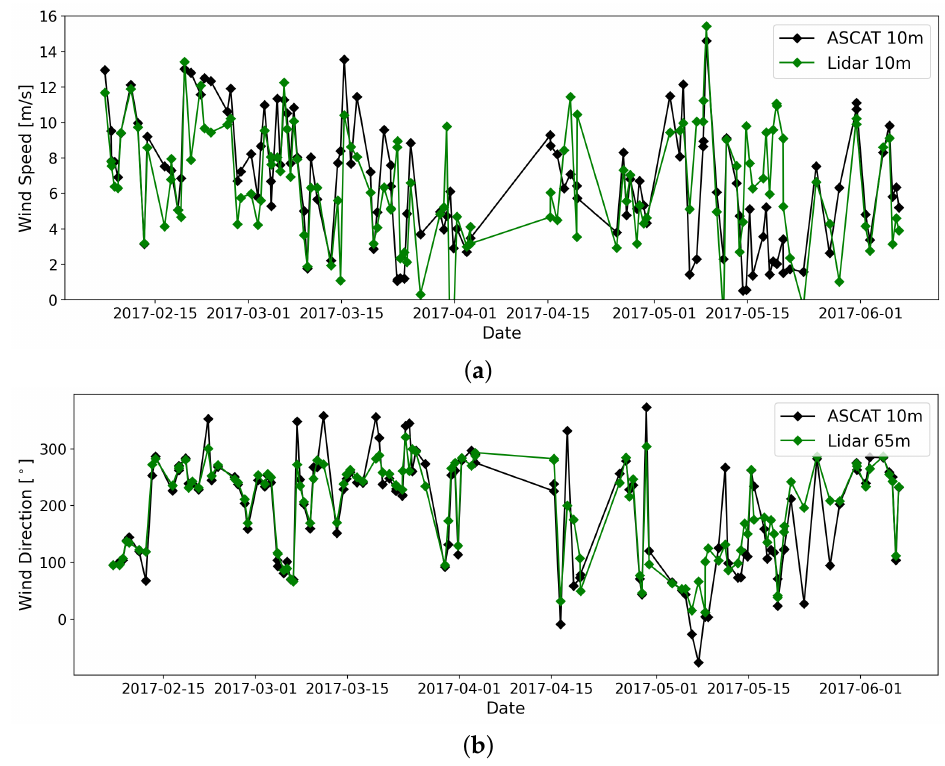
Figure 4. ASCAT-lidar co-location time series data: ( a ) 10 m wind speed extrapolation; ( b ) wind directions at different heights.